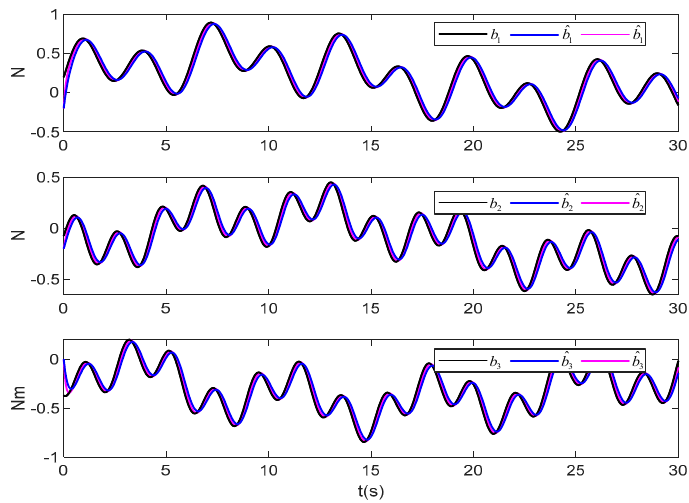
Figure 9. Disturbances and disturbances estimation ( β =